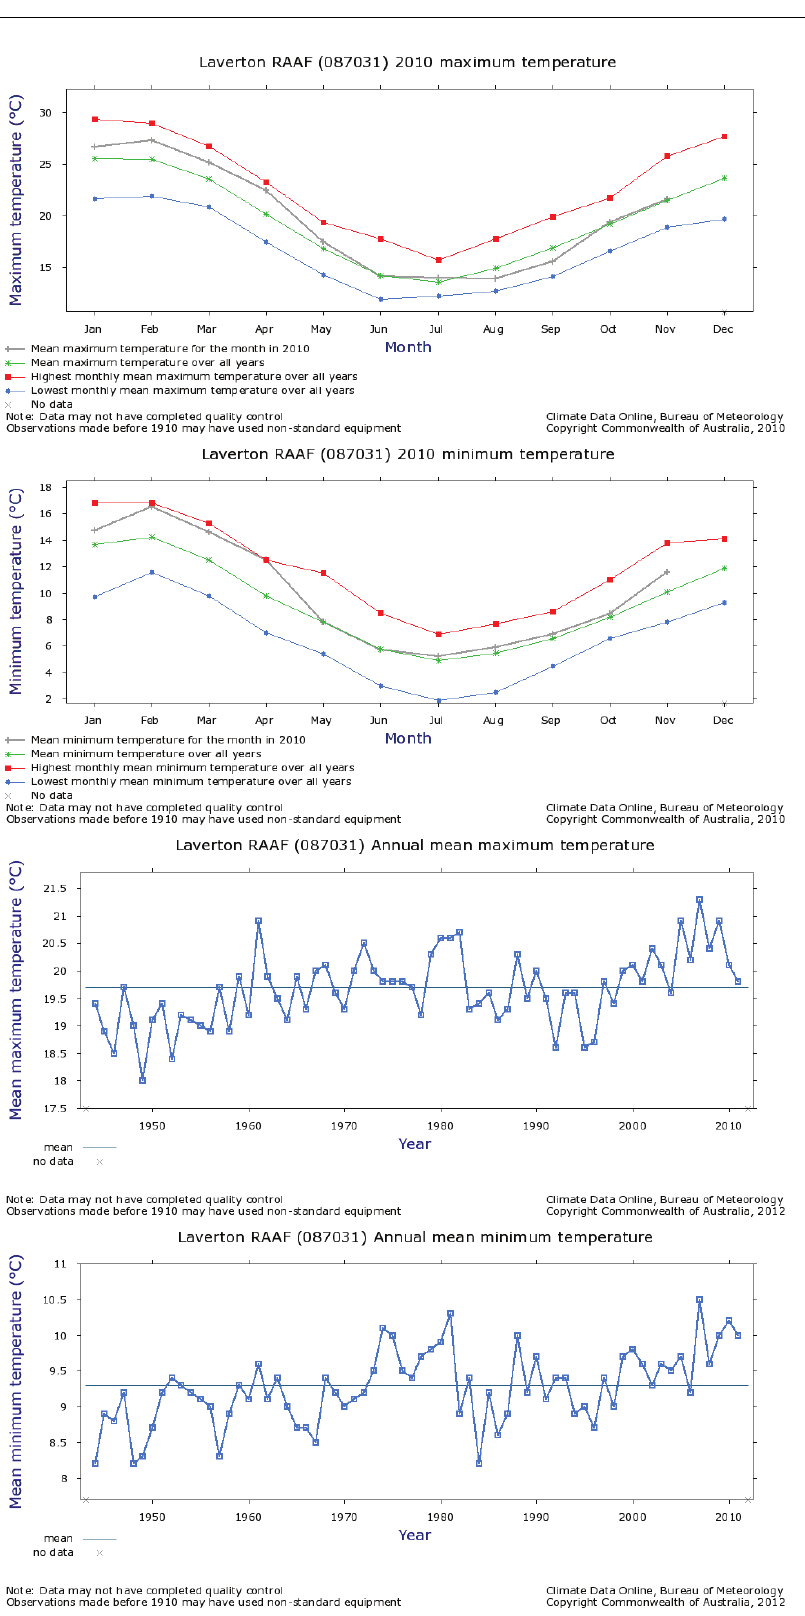
Figure 16. Australian Government Bureau of Meteorology temperature graphs for historical locations in Victoria, Aus-